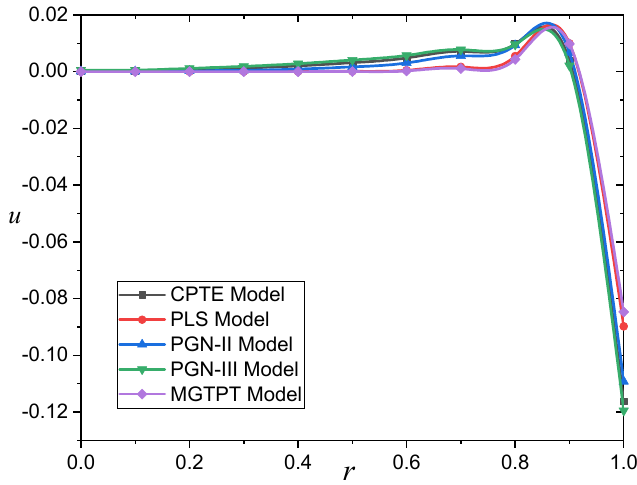
Figure 3. The carrier density (cid:1840) under different photothermal models. Figure 2. The displacement variation (cid:1873) under different photothermal models. Figure 2. The displacement variation u under different photothermal models. The five curves predicted by various photo-thermoelasticity models with and with- out thermal parameters for the carrier density (cid:1840) against the radial distance (cid:1870) are shown peaks at the surface of the sphere (cid:1870) = 1 and progressively falls as the radial distance in- creases until it approaches the steady state. The results in the case of the GN-III model are the PLS and PGN-II